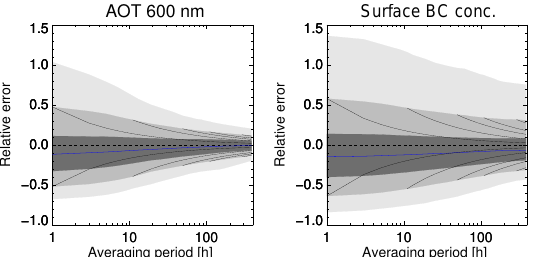
Figure 5. Relative spatial sampling error as a function of averaging period. The thin black lines are prognosis of the 9 and 91% quan- tiles in case these errors behaved like independent Gaussian errors √ n , with n the number of observations). Results from WRF- (i.e. 1 / Chem MADE over W. Europe. Further explanation in Sect. 3.2.